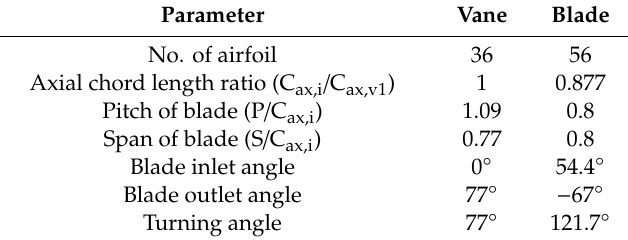
Figure 2. ( a ) Schematic of experimental facility; ( b ) Turbine vane, blade profile and rim seal configuration. Table 1. Turbine vane and blade parameters .